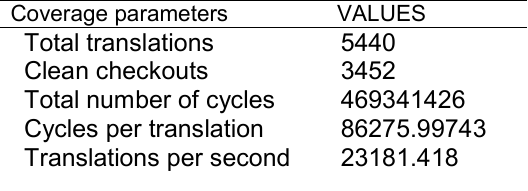
Table 1. Statistics collected by coverage tool with VTS1